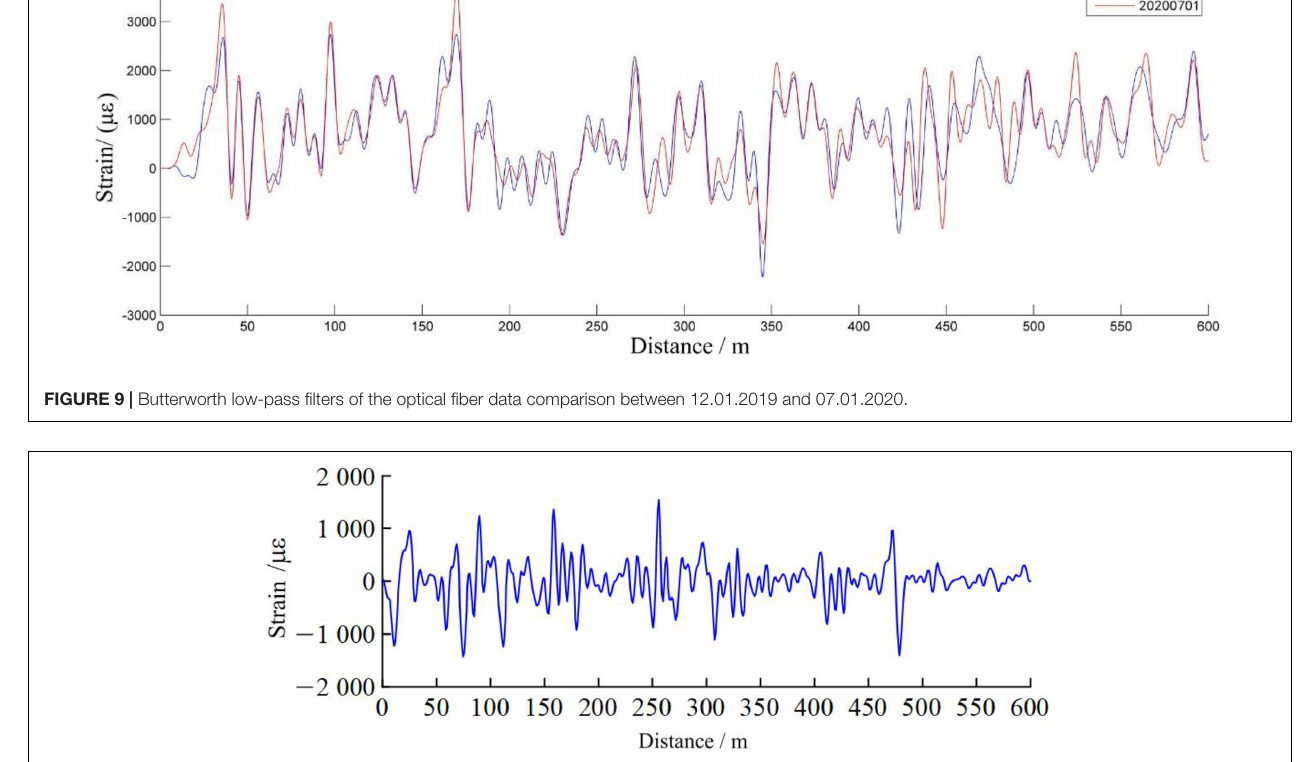
Frontiers in Earth Science |